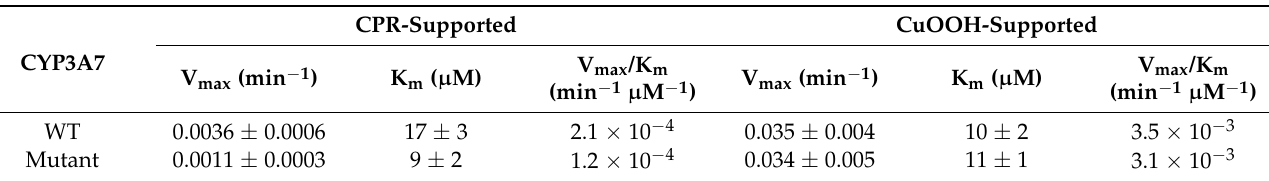
Table 1. Mutational impact on the BFC O-debenzylase activity of CYP3A7.